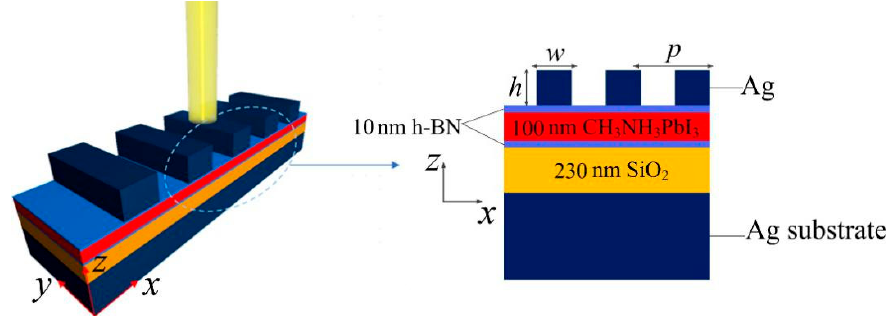
Figure 1. Structural figure of the dual-band (CH 3 NH 3 )PbI 3 -based perfect absorber.